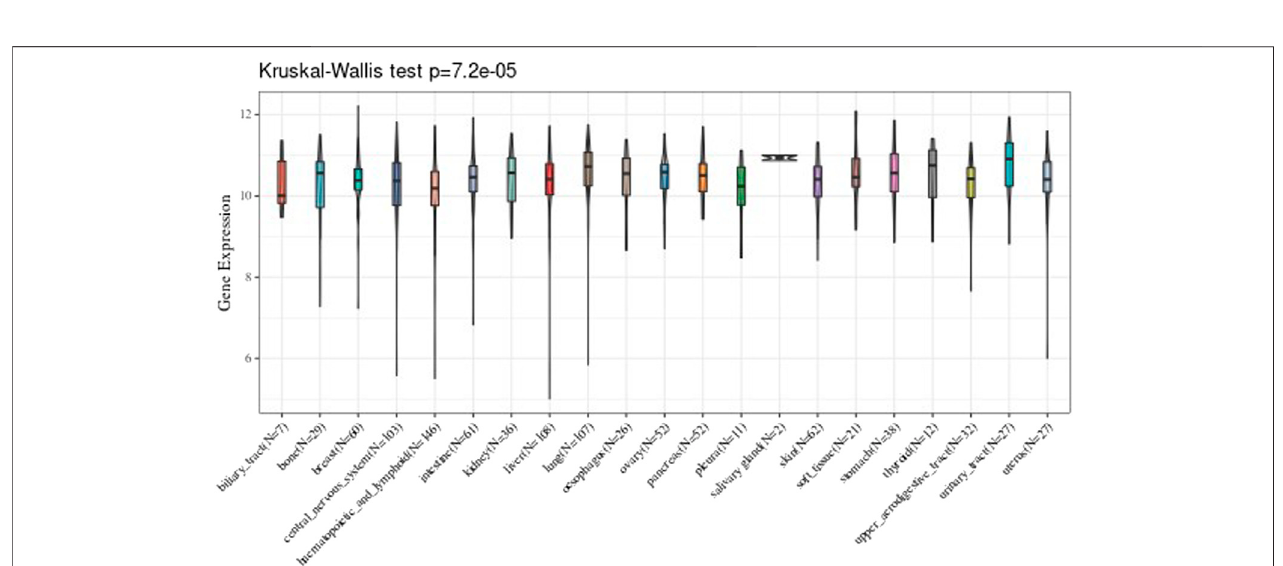
FIGURE 1 | The expression level of UBE2C gene in 31 tissues.